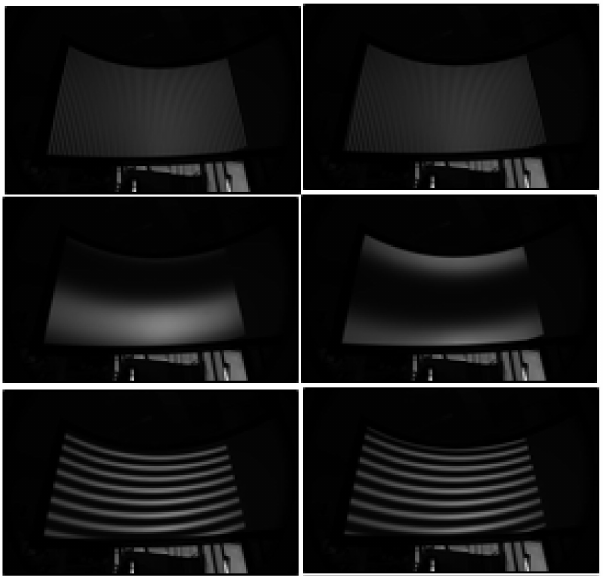
Figure 11. Partially captured feature stripe